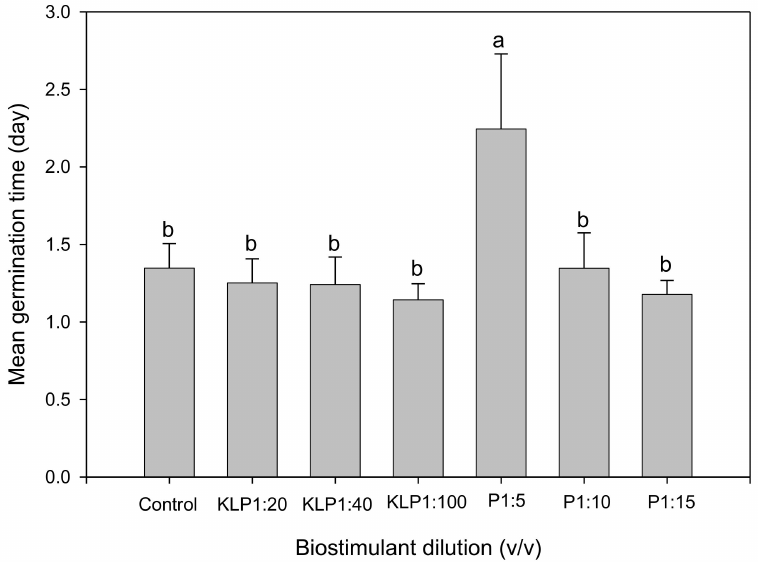
Figure 1. Effect of seed priming with biostimulants (KLP, Kelpak ® ; P, plant-growth-promoting rhizobacteria) on mean germination time of Abelmoschus esculentus seeds. Bars representing mean values and standard errors with different letters indicate statistically significant ( p ≤ 0.05) differences based on Fisher’s protected least significant difference test (Genstat 64-bit Release